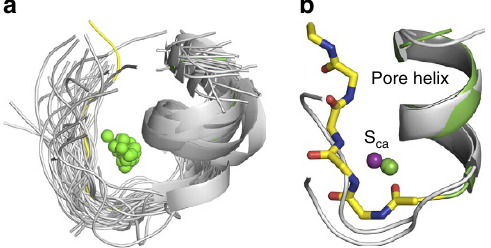
Figure 6 | The helix-turn S Ca binding motif ( a ) Superimposition of the Ca 2 þ binding motif of 47 PDB structures (grey cartoon) out of 369 hits obtained by analysis using the Metal3 database 43 , and the pore helix (green), selectivity filter (yellow) and the calcium ion at site S Ca of the NaKTs structure. ( b ) Superimposition of the NaKTs structure (pore helix—green; main chain atoms of selectivity filter—yellow sticks; Ca 2 þ at site S Ca —purple sphere) with representative motifs of PDB id 3K28 and 2IZ7 (grey cartoon) with o 1.0Å RMSD and their respective Ca 2 þ ions are shown in green